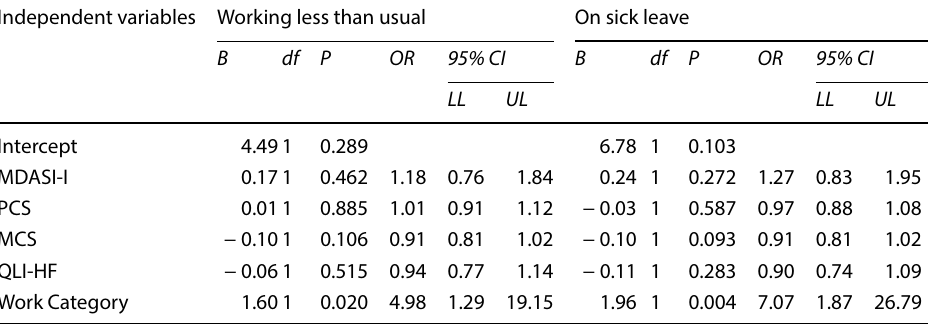
Table 4 Variables having significant effects on return- to-work at multinomial logistic regression